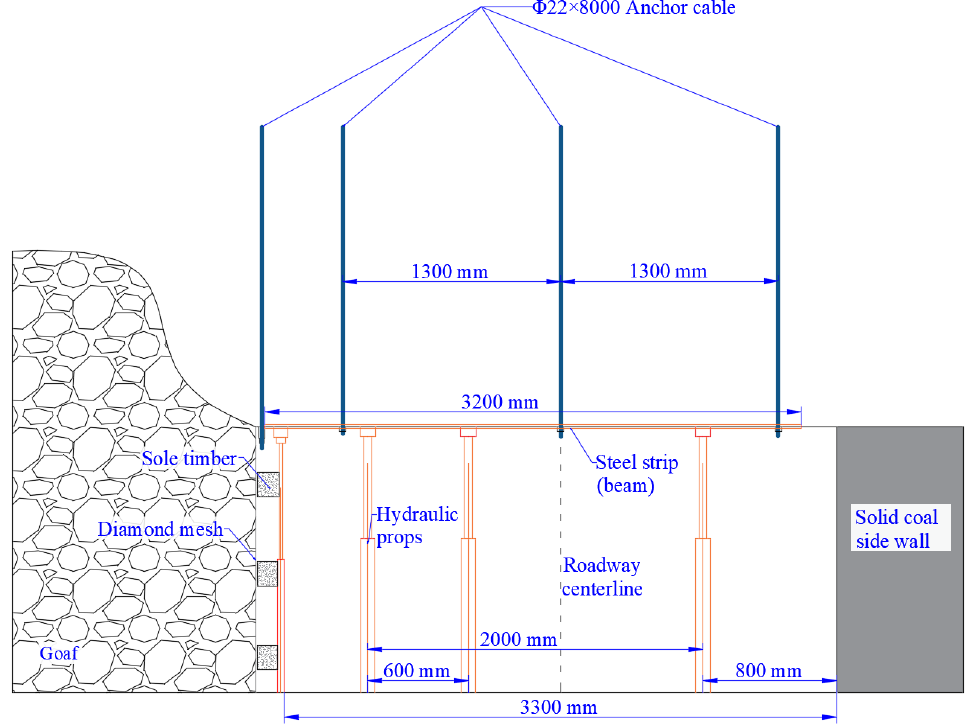
Figure 11. Overall support effect of the 1510 roadway.